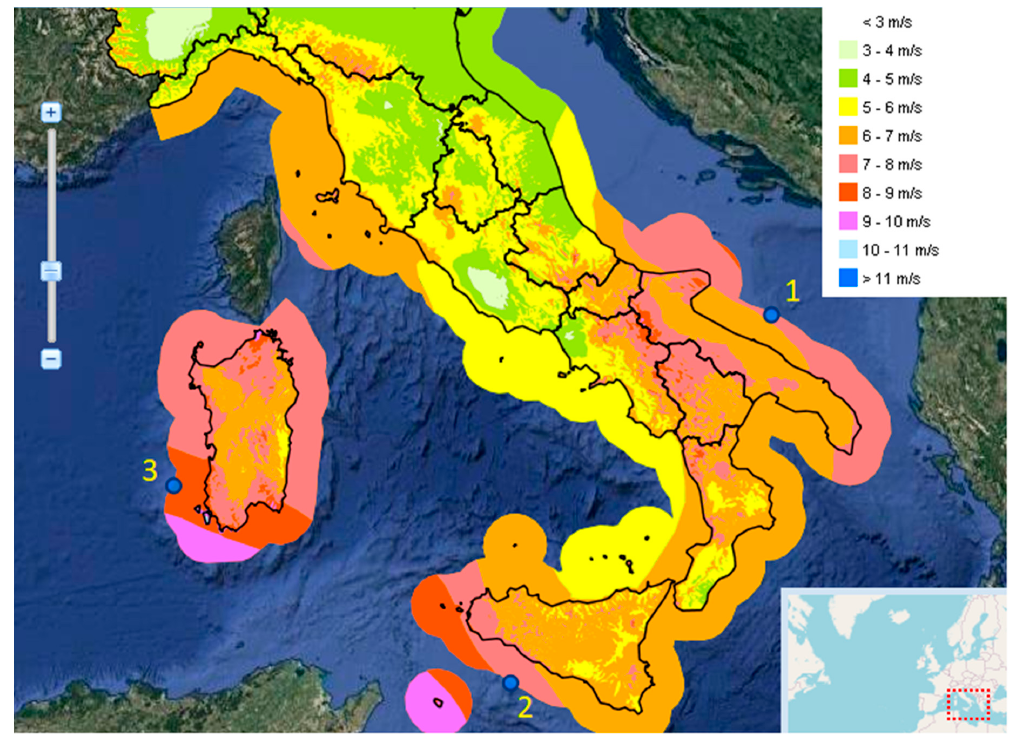
Figure 2. A view of ATLAEOLICO mean wind speed map at 100 m a.g.l./a.s.l. The three case study sites are shown: ( 1 ) Apulia, ( 2 ) Sicily, ( 3 ) Sardinia.